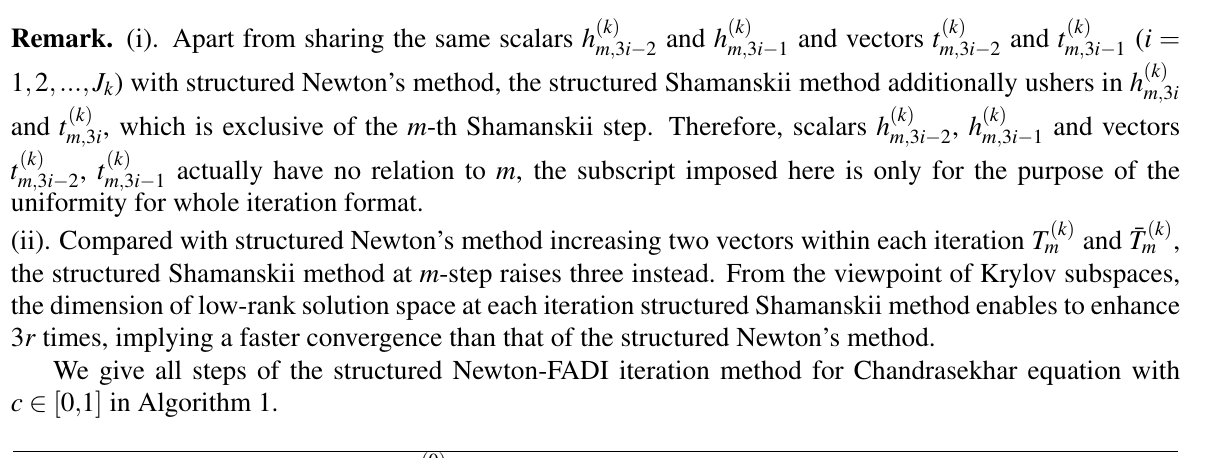
Algorithm 1. Inputs: Initial guess x ( 0 ) = 0 and tolerance tol . Outputs: x ∈ R n is approximative minimal positive solution of Chandrasekhar